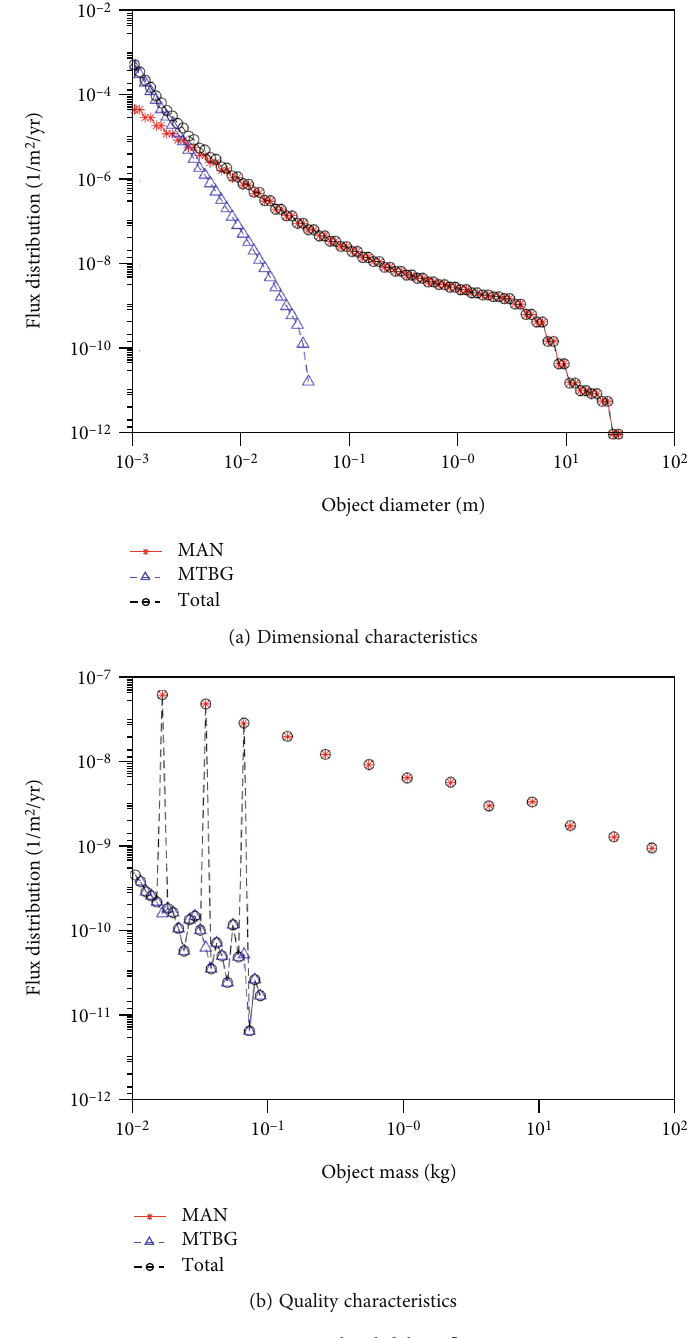
Figure 5: Orbital debris fl